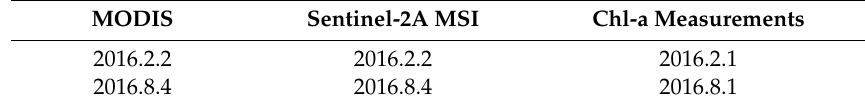
Table 2. Paired Dates of the Acquired Satellite Imagery and Chl-a Measurements of the Study